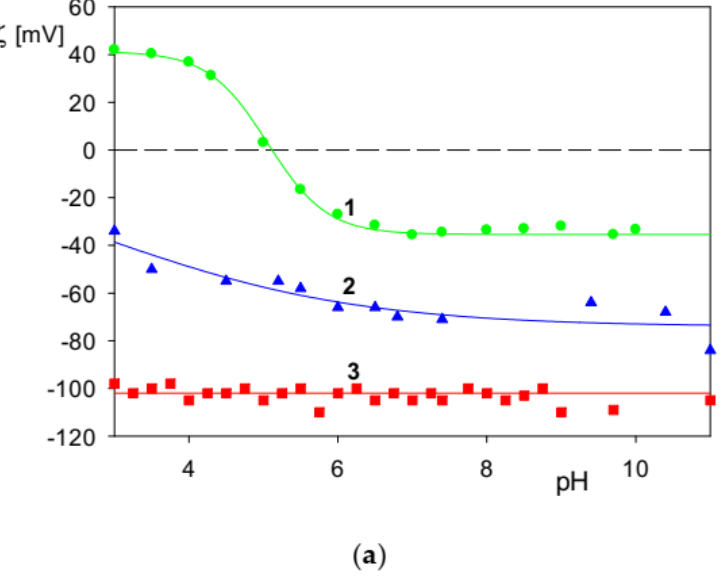
) 10 − 2 M; (2) ( ♦ ) 5 × 10 − 2 M; (cid:35)